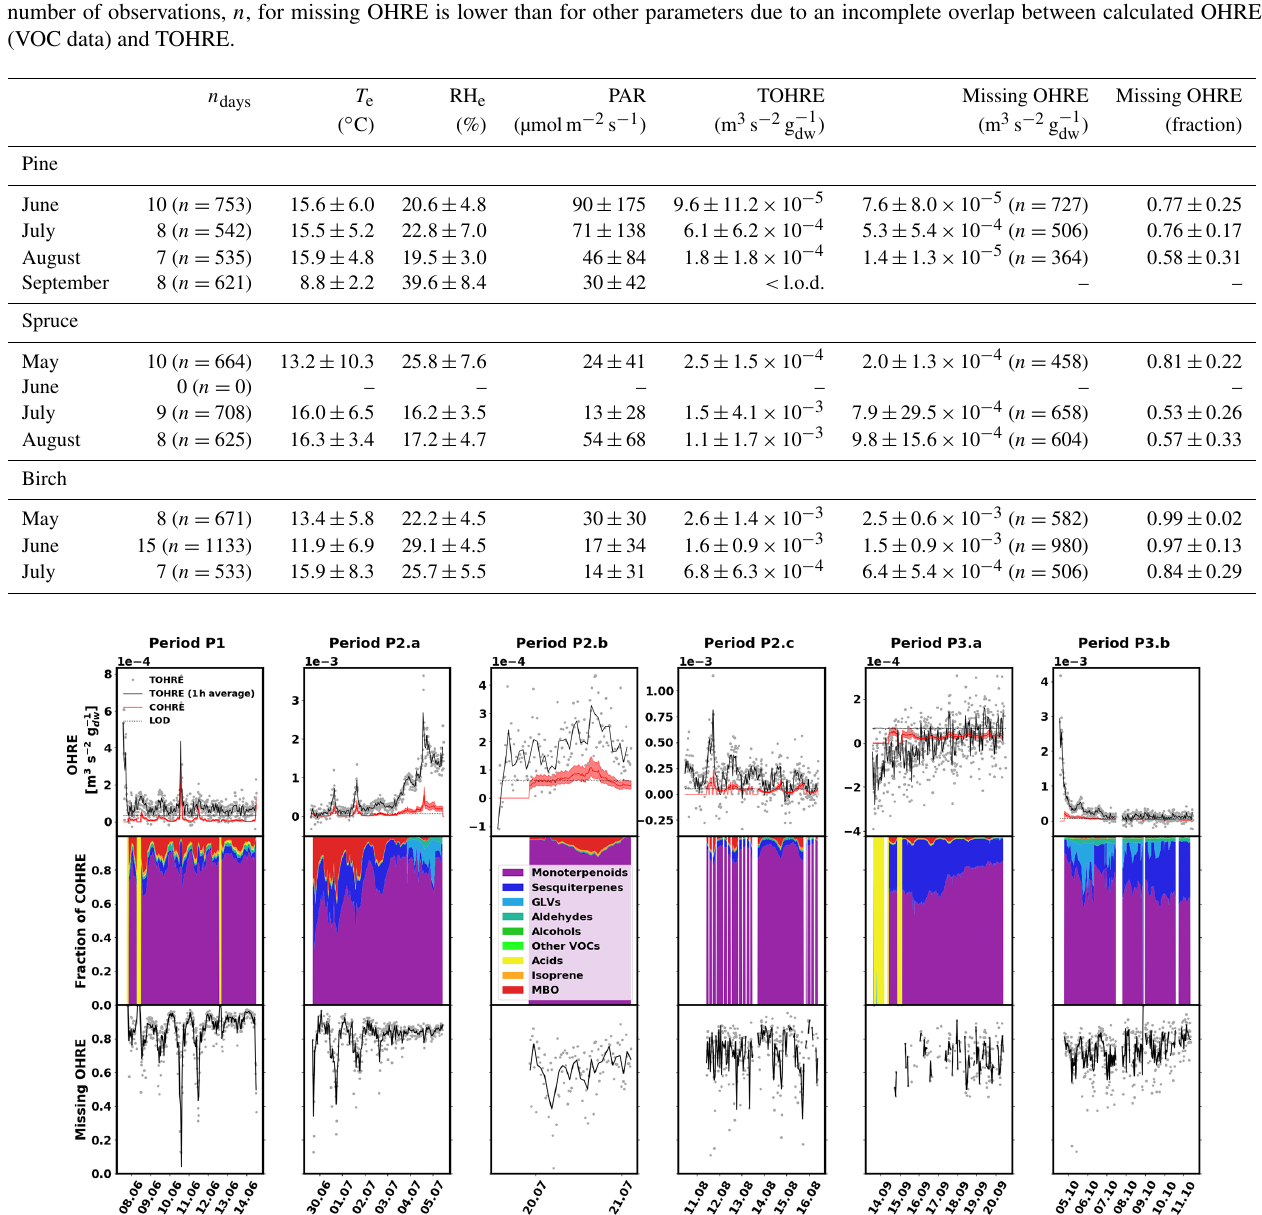
Figure 2. Measured total OH reactivity of the emissions (TOHRE), its 1h average values, and COHRE normalised to dry weight (top row) for pine. Fraction of the various contributions of chemical species to COHRE (middle row). Missing fraction of OHRE (bottom row). The periods are denoted “P” for “pine”, the number indicates which branch is being measured, and the letter indicates which period it is for the same